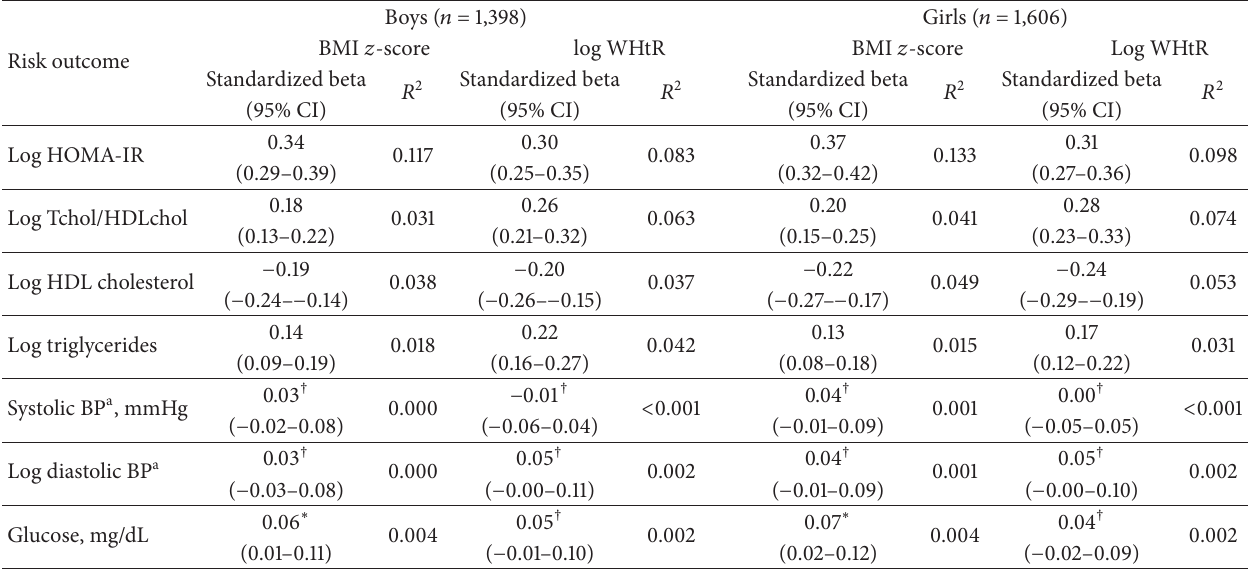
Table 4: Associations comparing standardized BMI 𝑧 -score with standardized WHtR for estimating risk variable outcomes among lower- fatness students ( 𝑁 =